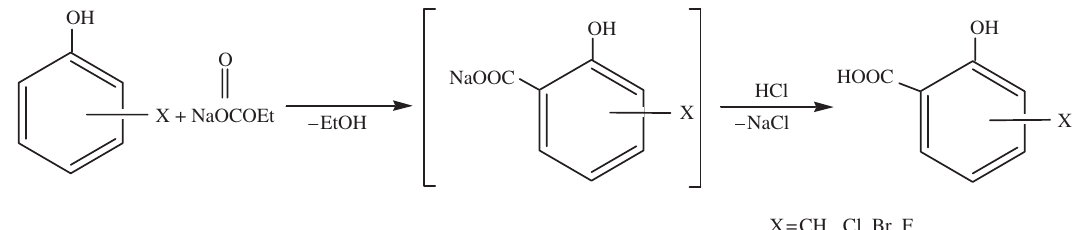
Scheme 1: Carboxylation of phenol and its derivatives with sodium ethyl